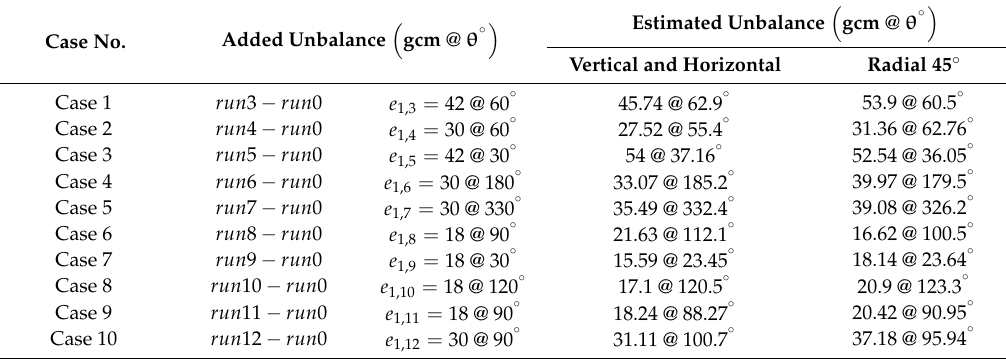
Table 3. Comparison between the actual and estimated unbalances (disc D1).